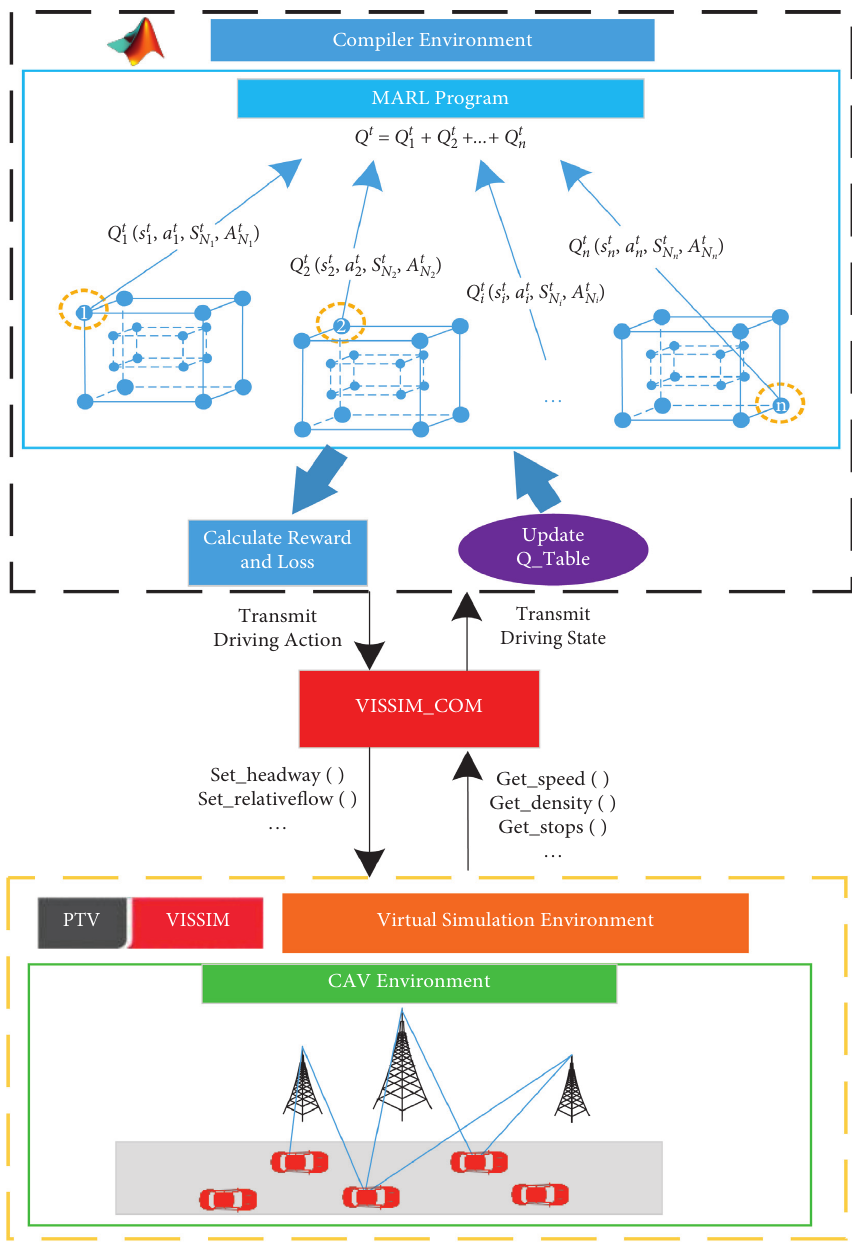
Figure 3: MARL training